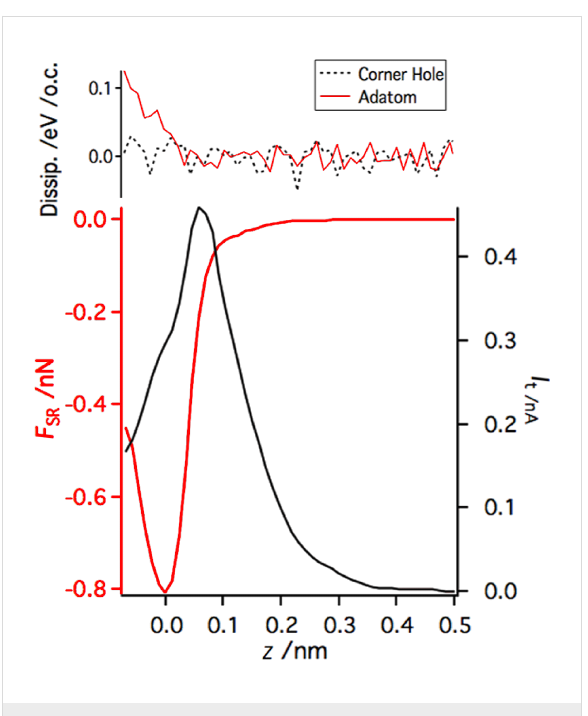
Figure 11: Corrected dissipation for damping measured above the adatom and above the corner hole. The corner hole shows only nondissipative interactions. The adatom starts to show dissipation when the z approach reaches and exceeds the force maximum.